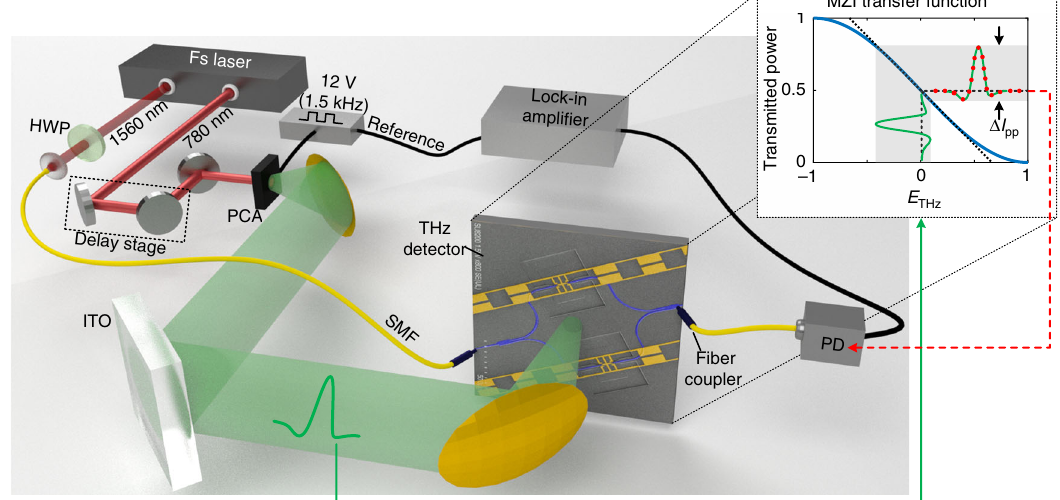
Fig. 2 THz time-domain electro-optic sampling setup. A dual wavelength laser system provides the pump pulses (780 nm) and the optical IR probe signal (1560 nm). The 780 nm signal illuminates the PCA and drives the generation of phase-locked THz pulses. A square bias with a frequency of 1.5 kHz and an amplitude of 12 V is applied to the PCA. The IR probe beam is coupled by means of a single mode fi ber (SMF) directly to the on-chip Si input waveguide. A half-wave plate (HWP) controls the linear polarization state of the IR probe to be oriented perpendicular to the plasmonic gap. A motorized delay stage controls the relative delay between the THz signal and IR probe. The probe signal is then guided through the MZI con fi guration where it probes the amplitude of the THz signal. The output intensity of the probe signal depends on the THz signal as dictated by the MZI transfer function (see inset). The red points depict different relative delays between the optical and THz pulses. Finally, a lock-in ampli fi er is employed to demodulate the electro-optic signal at the frequency of the driving voltage of the